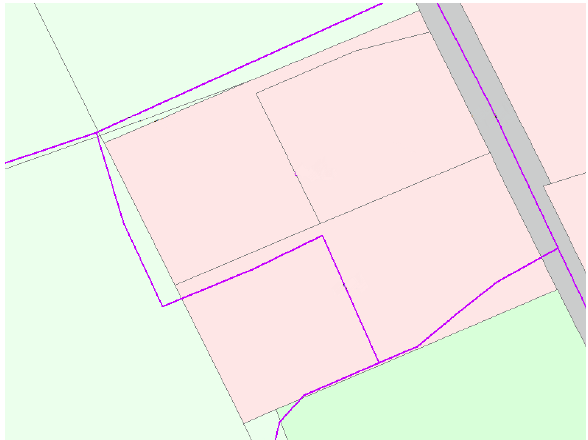
Figure 1. Overlay of ALKIS (filled) and ATKIS (hollow violet